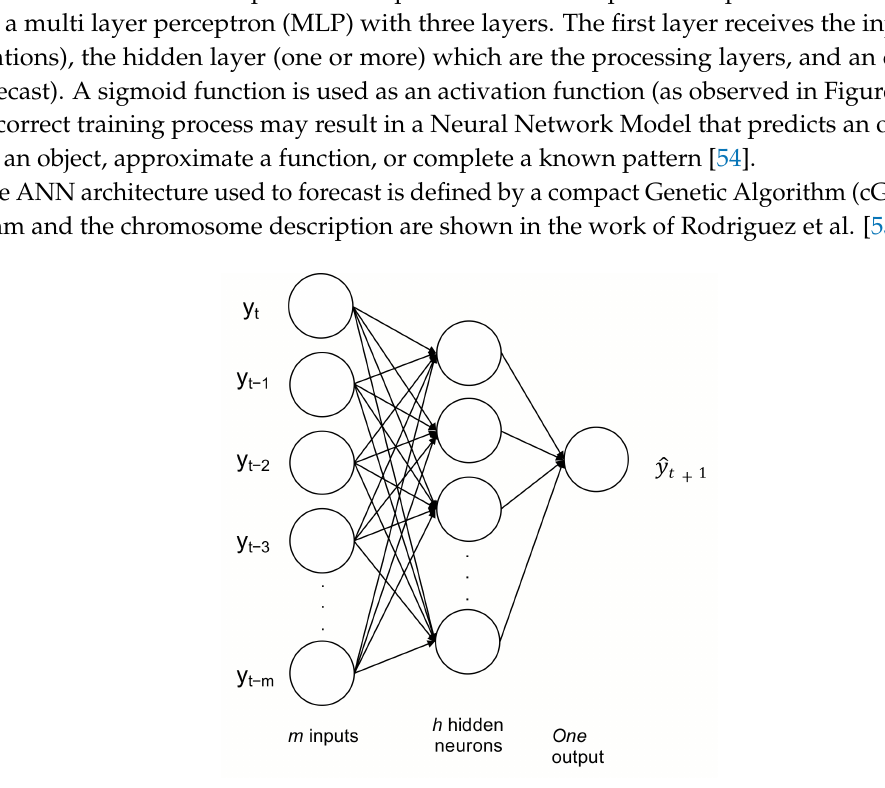
Figure 5. Artificial Neural Network (ANN) topology which starts with the input layer ( m past observations), continues with the hidden layer ( h hidden neurons), and ends with an output layer (a single output ˆ y t + 1 ). For general Artificial Neural Network terminology, see